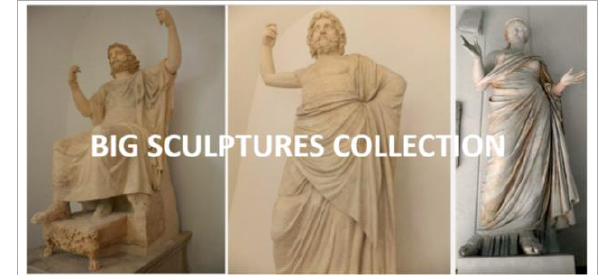
Figure 10. The big sculptures category: step